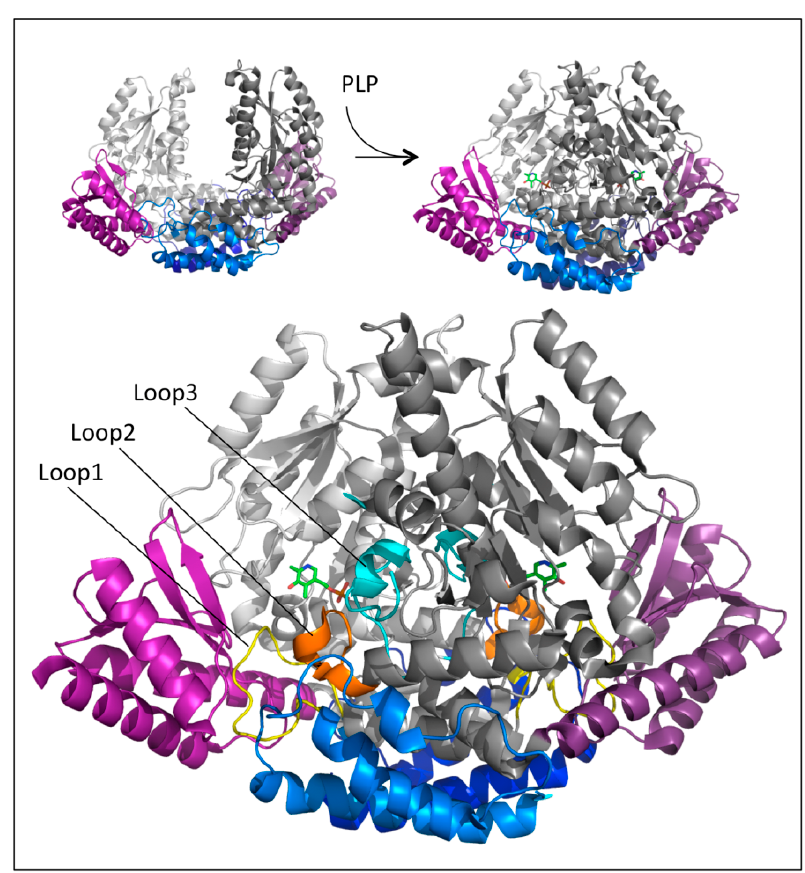
Figure 4. Structural regions involved in the apo-to-holo transition of DDC. Global conformational change accompanying the transition from the apo to the holo form of DDC. The N-terminal, large, and C-terminal domains are colored blue, gray, and magenta, respectively. The two monomers are distinguished by dark and light colors. The PLP molecules are represented as green sticks and loops 1, 2, and 3 are highlighted in yellow, orange, and cyan, respectively. Image was rendered by PyMol software (Schrödinger).